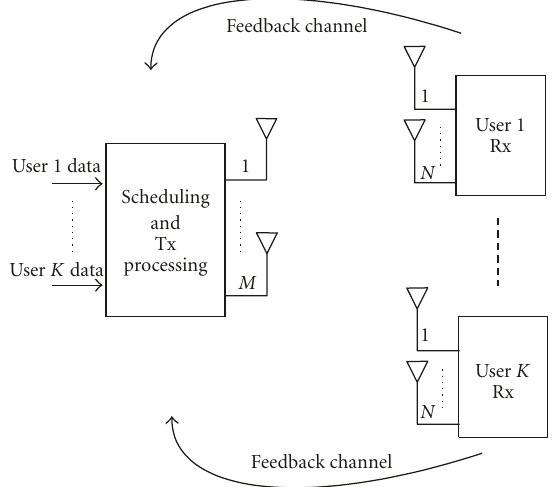
Figure 1: Block diagram of an MU-MIMO